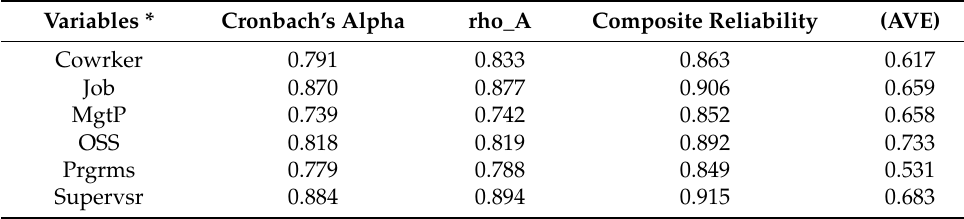
Table 3. Construct reliability and validity.